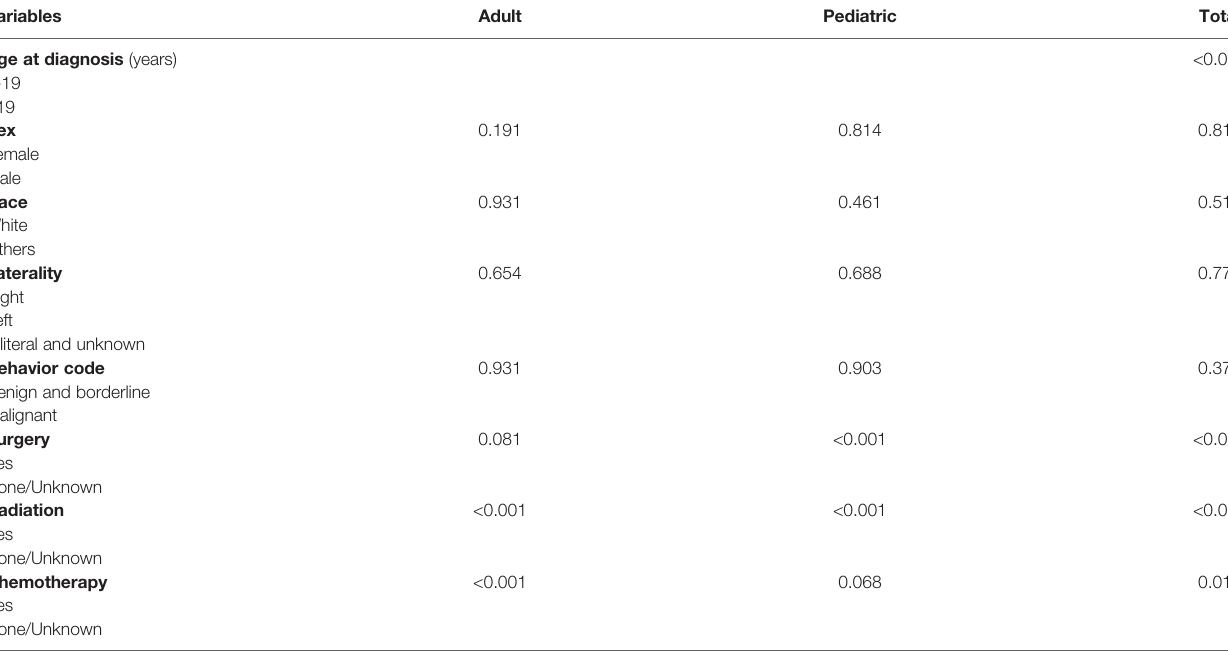
TABLE 4 | The results of the log-rank